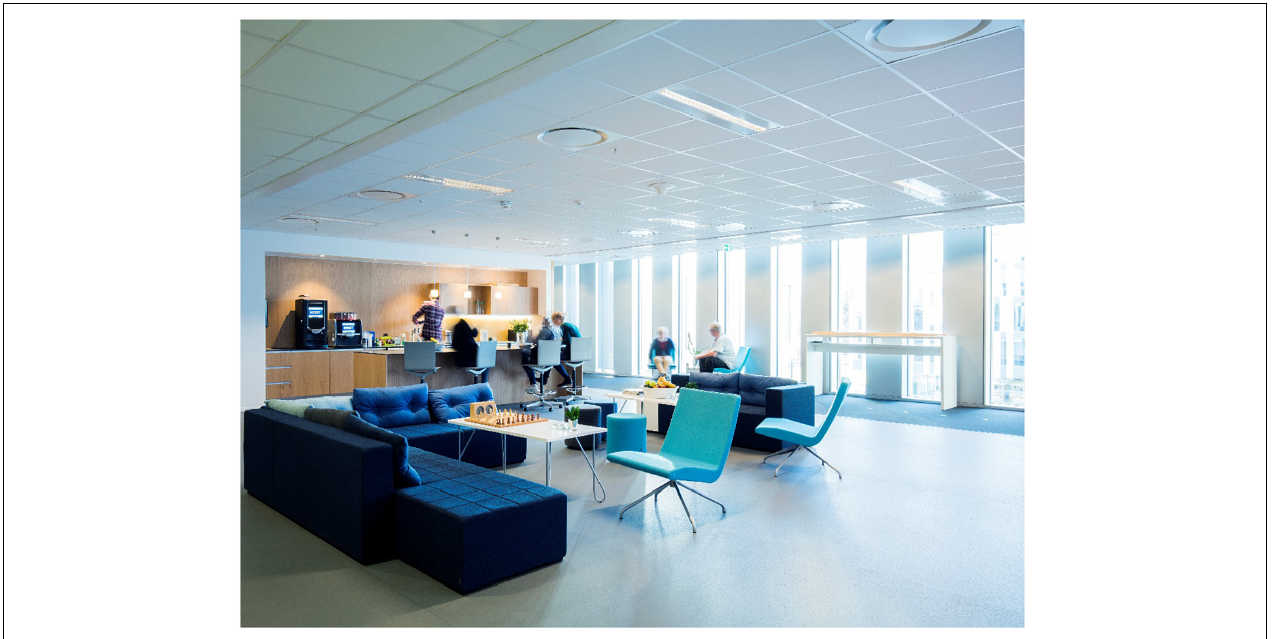
FIGURE 1 | Small open-plan office in